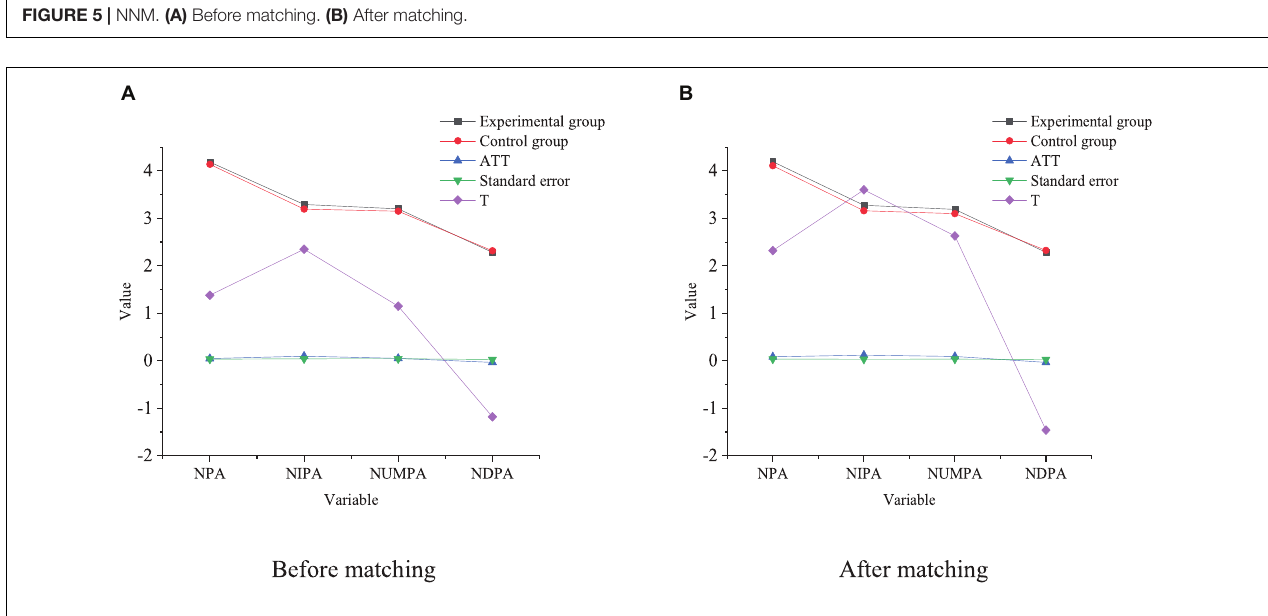
FIGURE 6 | RM. (A) Before matching. (B) After